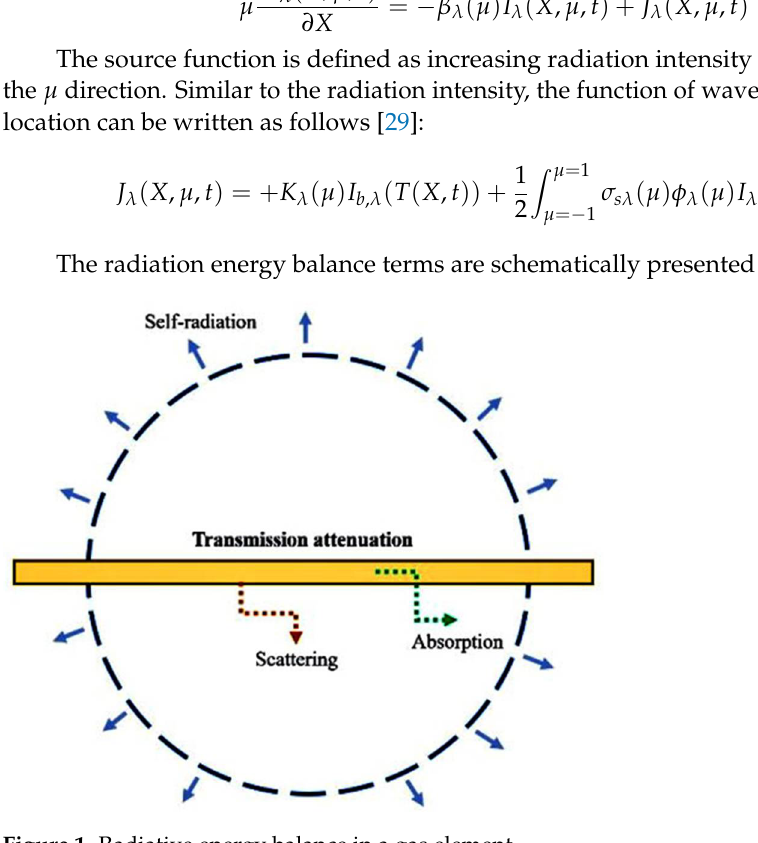
Figure 1. Radiative energy balance in a gas element.